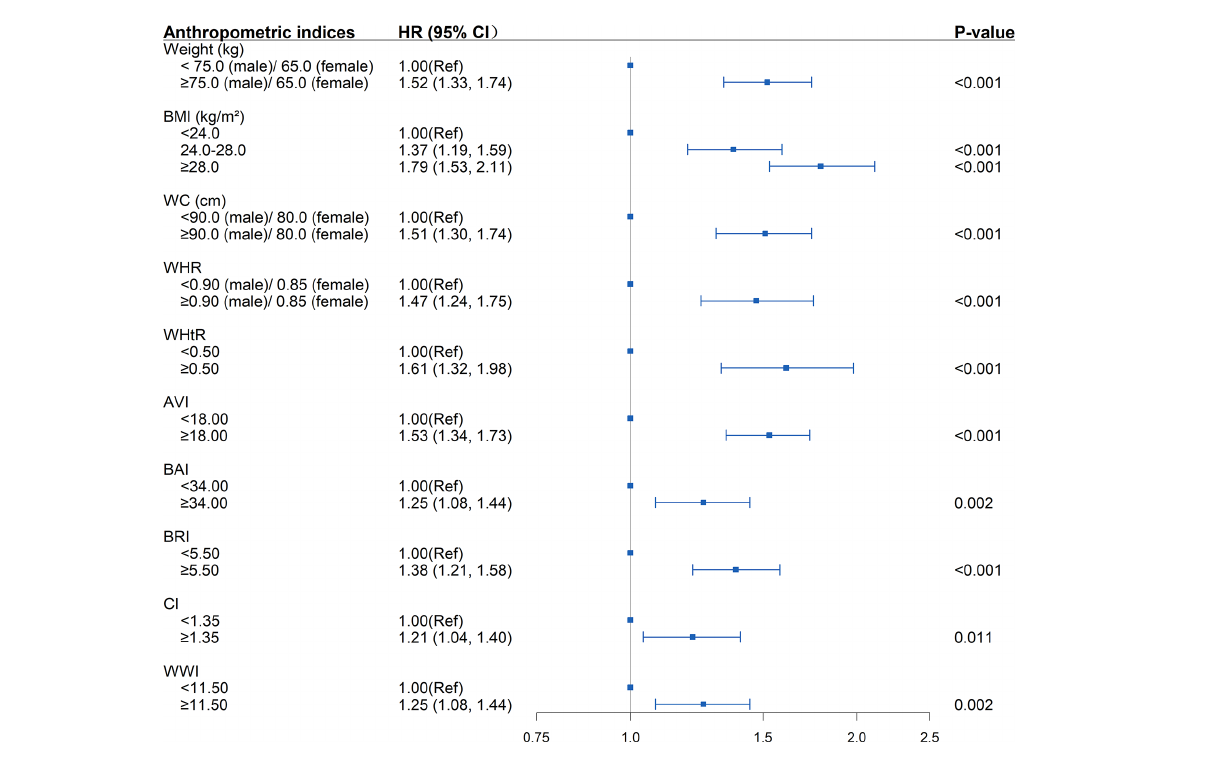
FIGURE 2 | Association between separate anthropometric indices with the development of diabetes (weight, body mass index [BMI], waist circumference [WC], waist-to-hip ratio [WHR], waist-to-height ratio [WHtR], abdominal volume index [AVI], body adiposity index [BAI], body roundness index [BRI], conicity index [CI], weight-adjusted-waist index [WWI]). The correlation was assessed by multivariate cox regression analysis, adjusted by sex, age, smoking status, drinking status, and family history of diabetes at baseline and differences of FPG, TG, TC, HDL, LDL, SBP, DBP between the baseline and follow-up. Hazard ratios (HRs) of the anthropometric indices were represented as the squares and 95% con fi dence intervals (CIs) by the lines through the